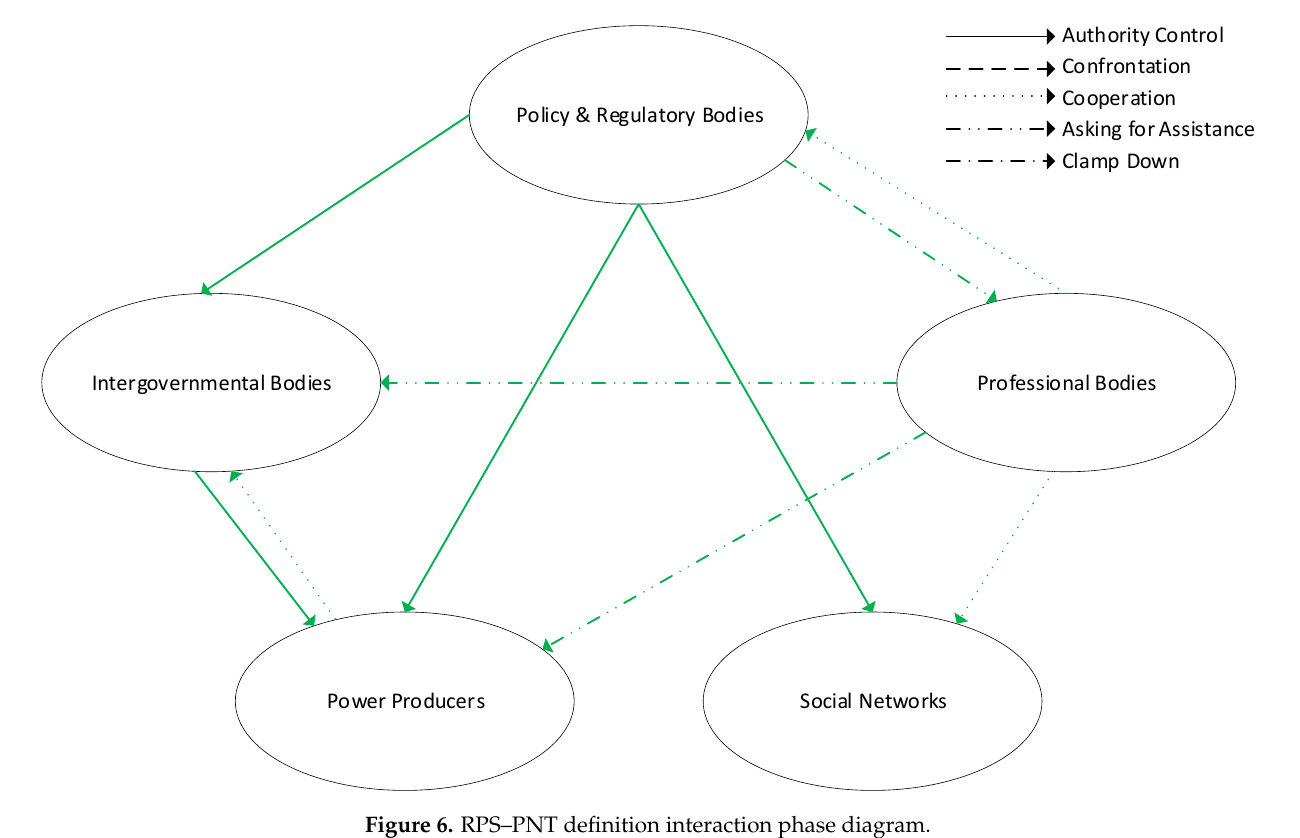
Figure 6. RPS–PNT definition interaction phase diagram.